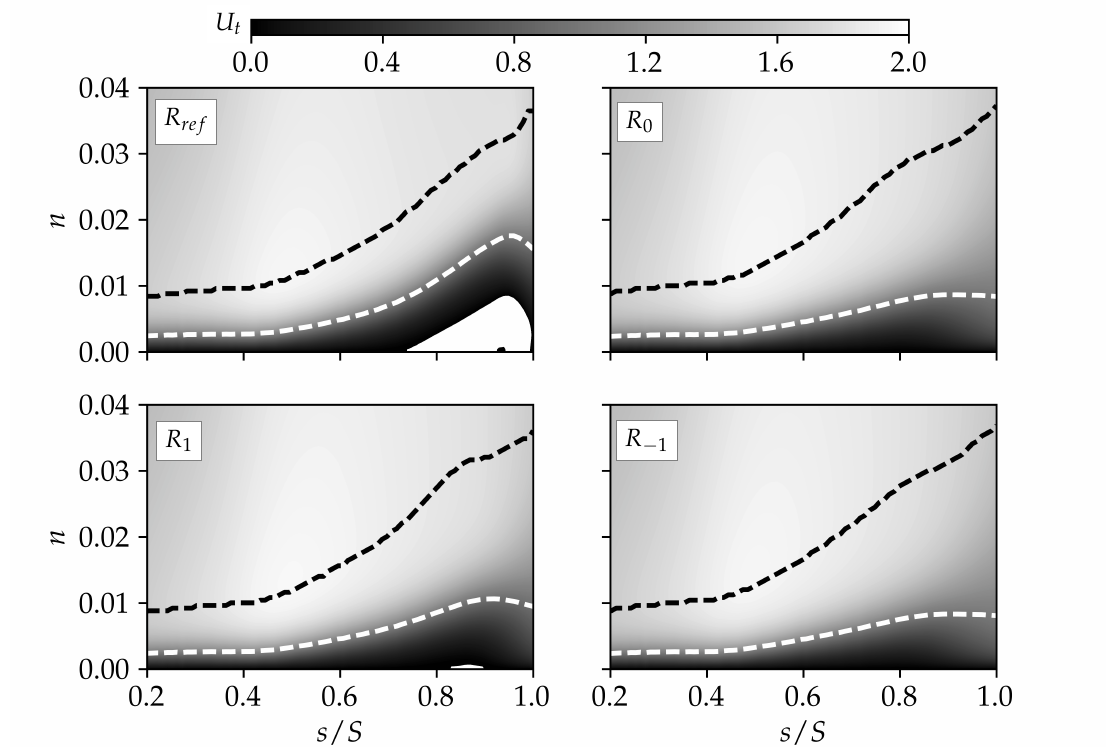
Figure 5. Velocity contours, edge of the boundary layer (black dashed line) and displacement thickness, δ ∗ , (white dashed line) along the suction surface for the non-rotating bar case R 0 , the counter-clockwise rotating bar case R 1 , the clockwise rotating bar case R − 1 and the reference case R ref without